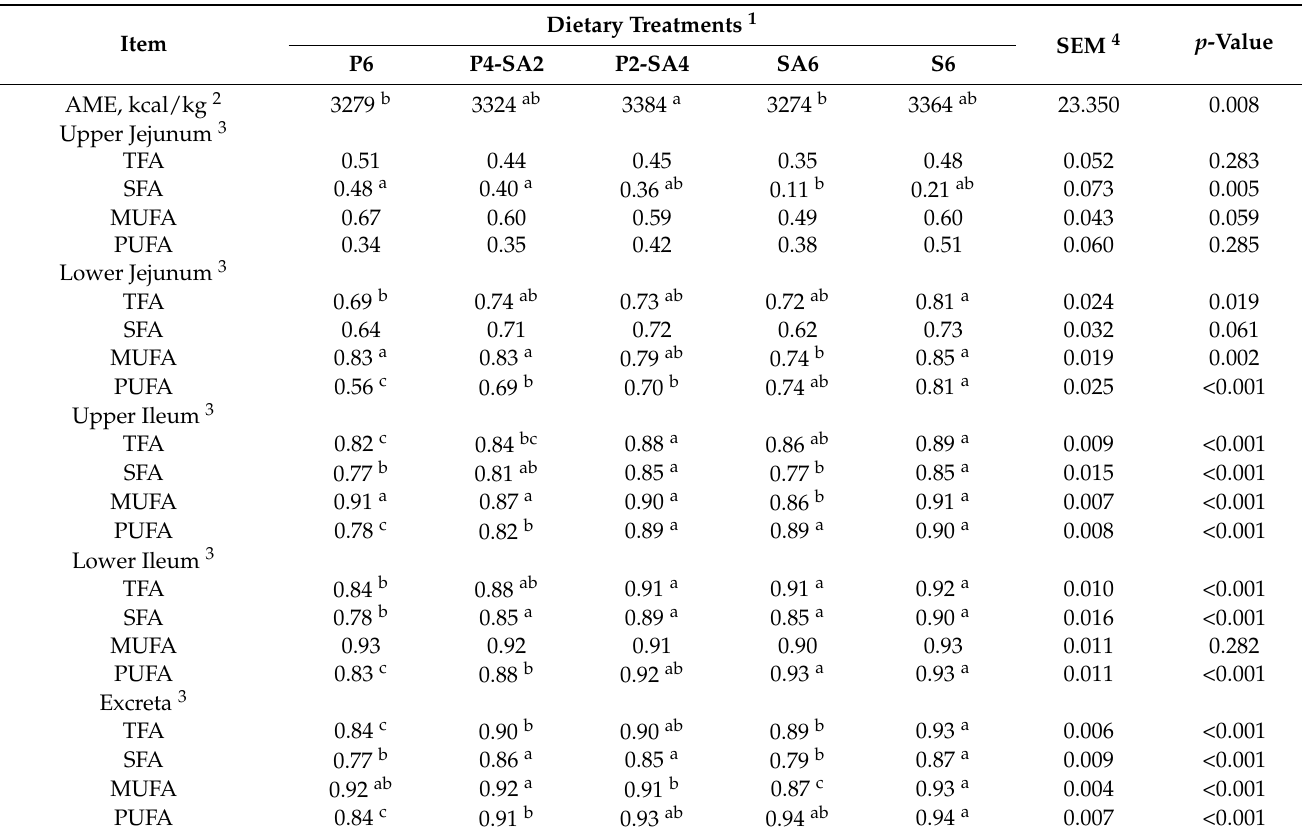
Table 8. Apparent metabolizable energy values and apparent fatty-acid digestibility coefficients in the different intestinal segments and total tract digestibility according to various fat sources in the diet in 35-d-old broiler